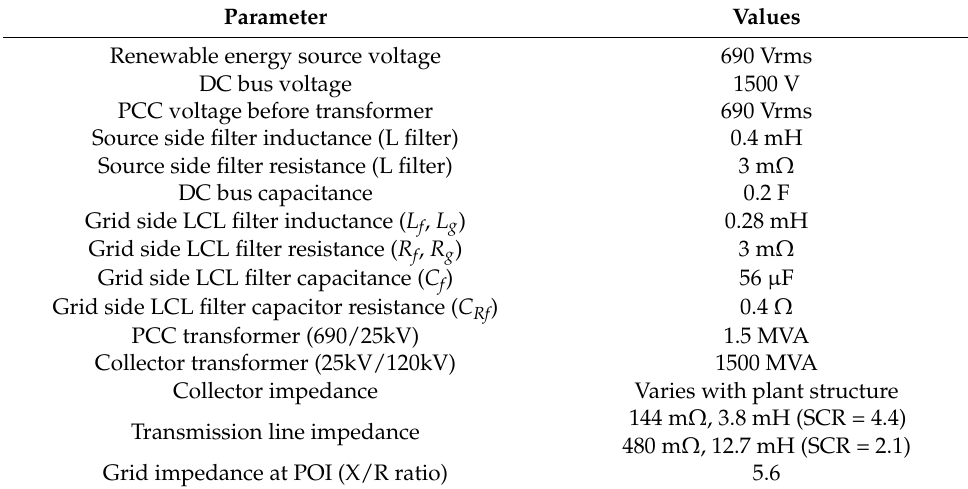
Table 2. System parameters of the IBR plant